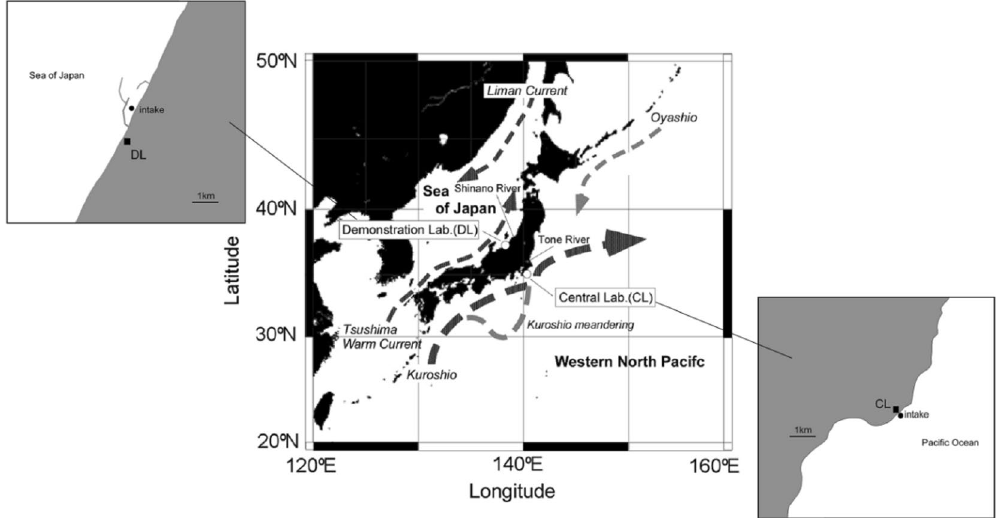
Figure 1. Location of the oceanic pH monitoring sites/laboratories on the Sea of Japan and North Pacific coasts. This figure also shows the major rivers (Shinano and Tone) that are closest to each laboratory and the main oceanic currents that surround